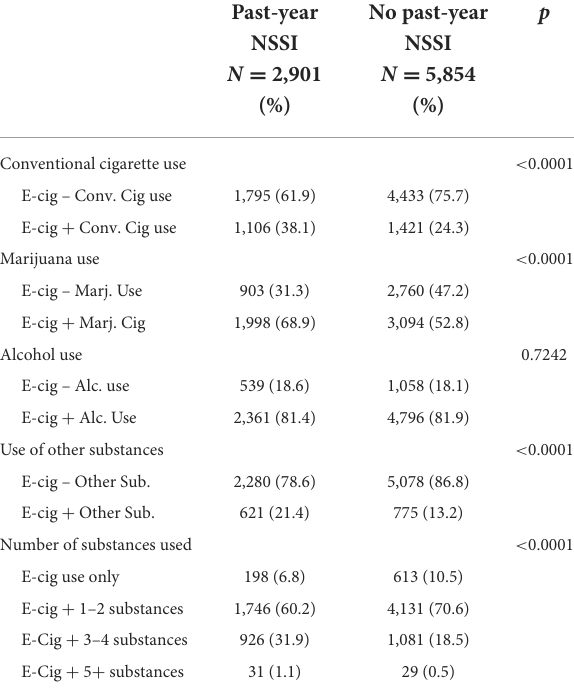
TABLE 4 Concurrent substance use behavior among individuals using e-cigarettes (N = 8,755), by past 12-month